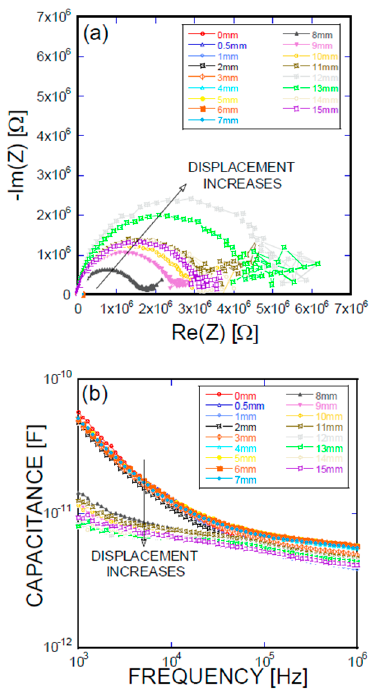
Figure 8. ( a ) Impedance spectra and capacitance Bode plots as a function of displacement obtained for a BH-type Ni/Ti SMA fiber pullout; ( b ) mechanical load and electrical resistance extracted as a function of wire displacement, obtained for a BH-type Ni/Ti SMA fiber pullout.